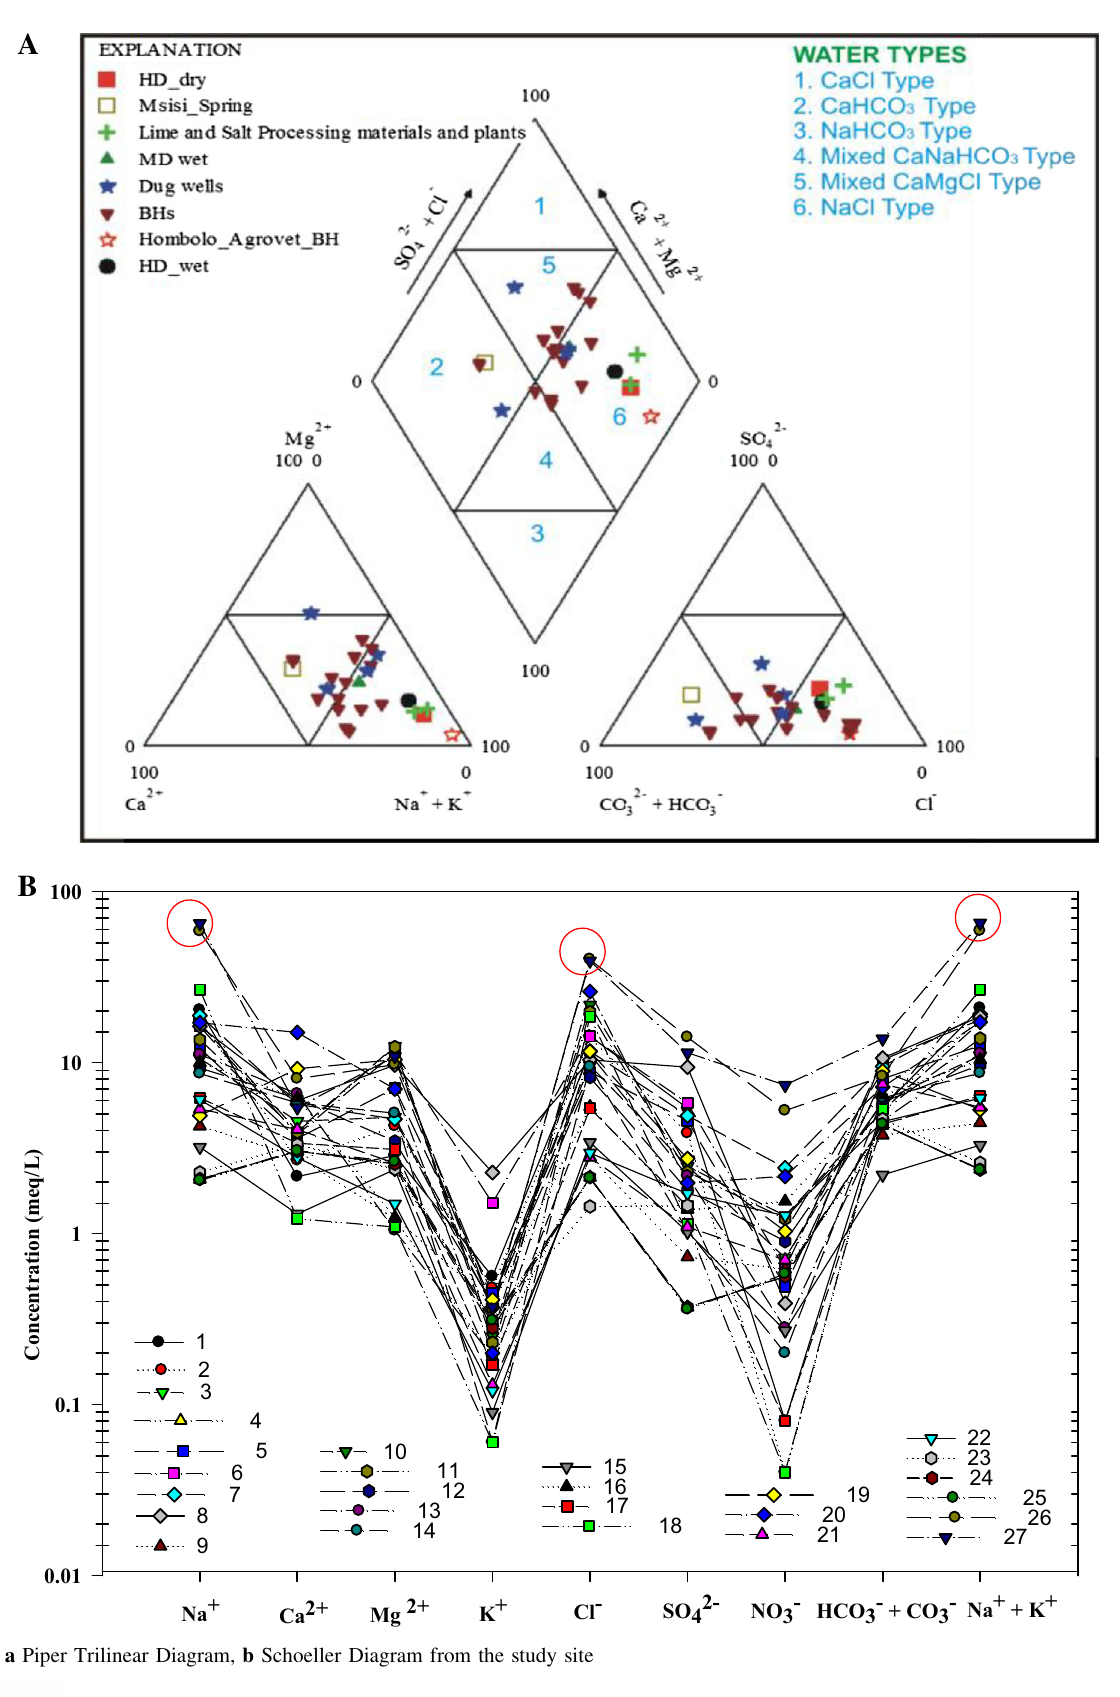
Fig. 7 a Piper Trilinear Diagram, b Schoeller Diagram from the study